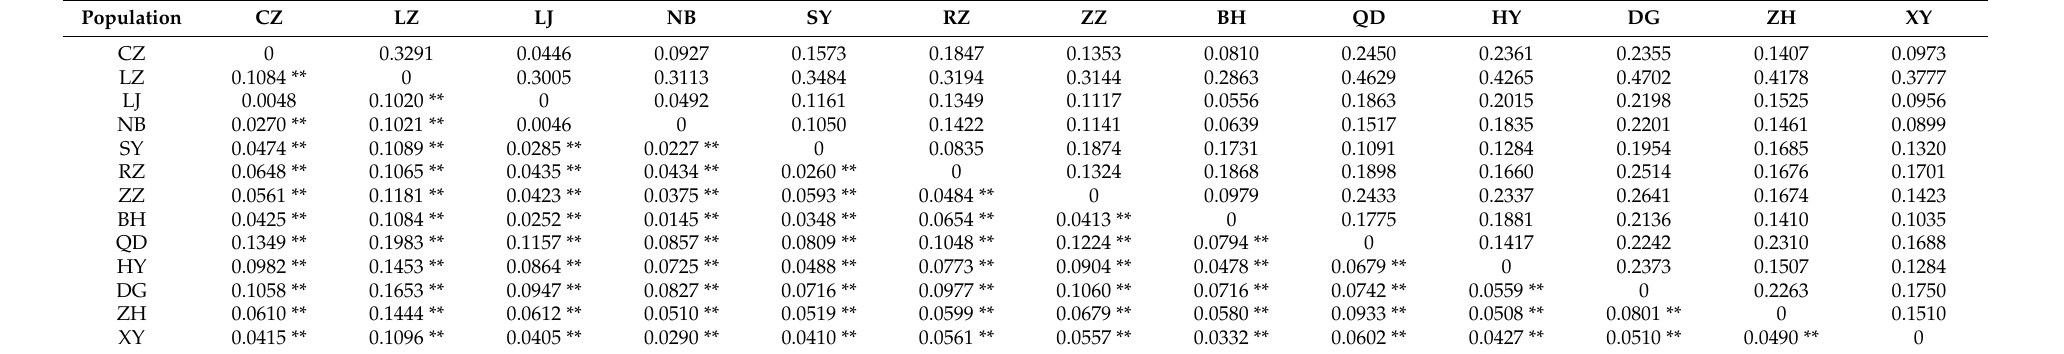
Table 3. Pairwise F st (under diagonal) and Nei’s genetic distance Ds (above diagonal) of R. philippinarum